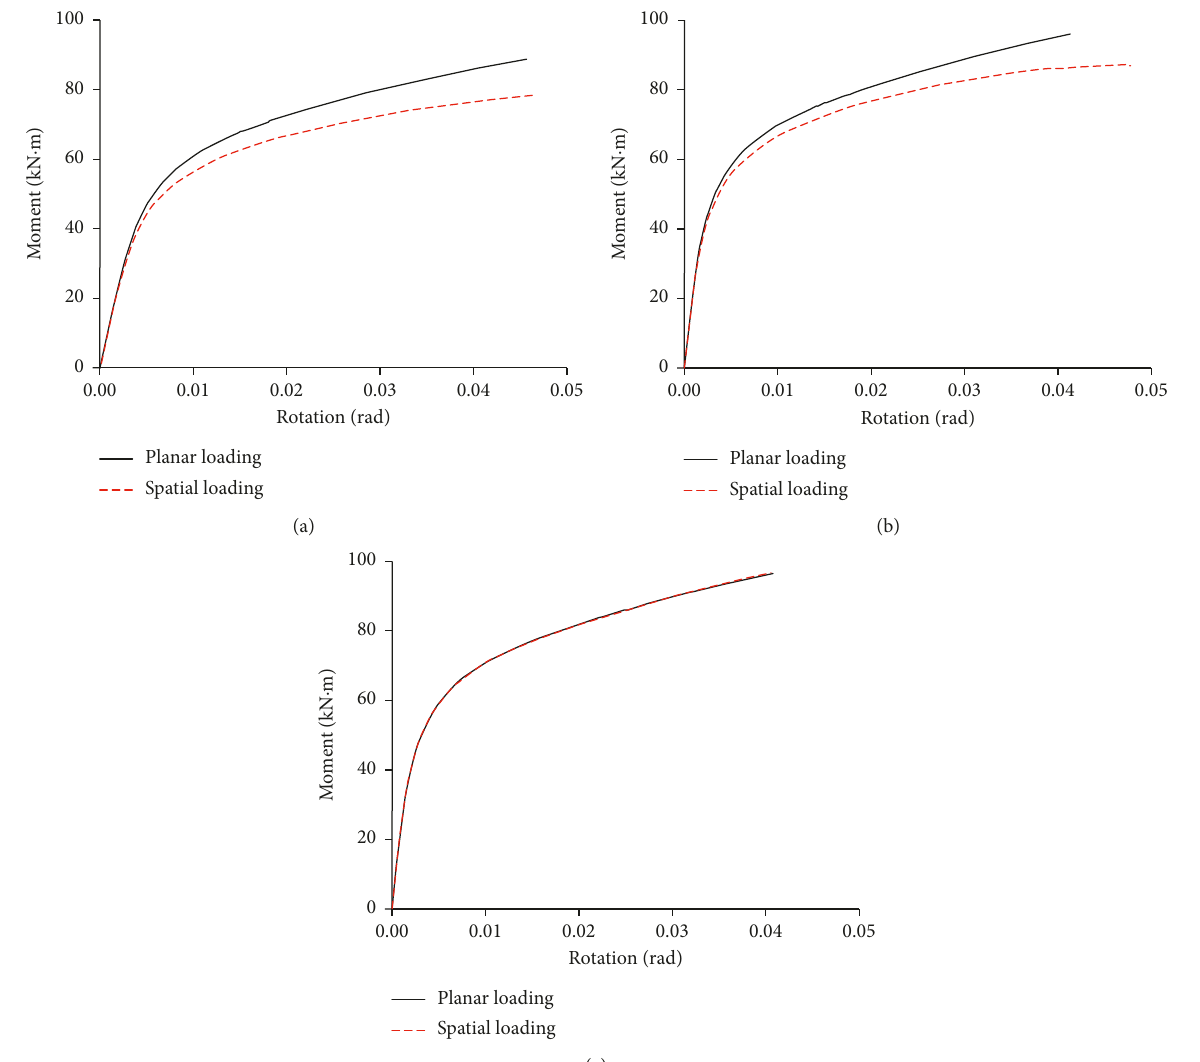
Figure 10: Moment-rotation curves of the spatial FE model under different loading modes. (a) YZ-1. (b) YZ-2. (c) YZ-3. Table 7: Mechanical properties of the spatial joints.